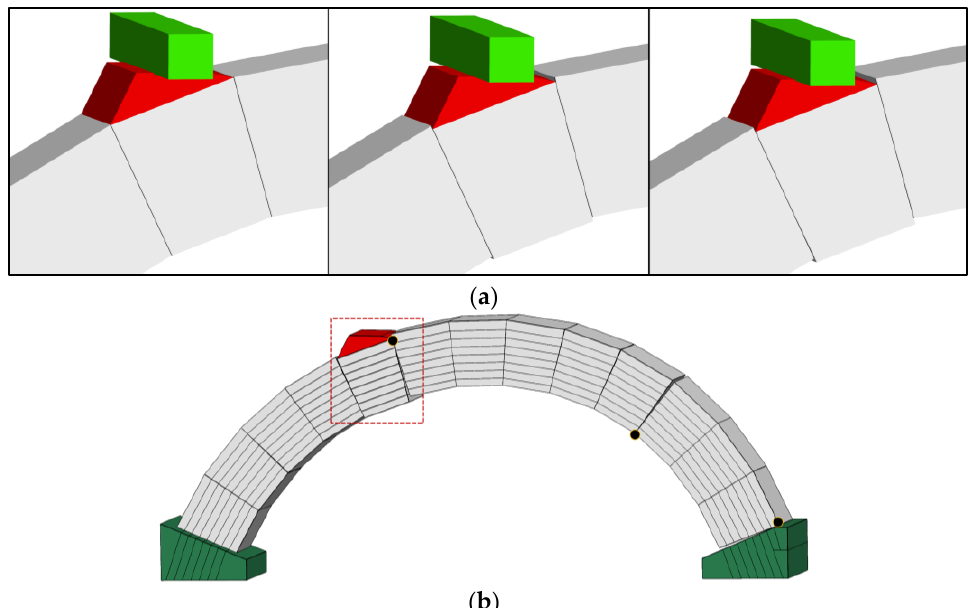
Figure 12. ( a ) Progressive sliding mechanism at the joints under impact loading (free-falling object – snapshots are taken at 𝑡 = 0, 𝑡 = 2.7 ms and 𝑡 = 8.9 ms — from left to right ) and ( b ) overall re- sponse of the masonry arch (M60H30).